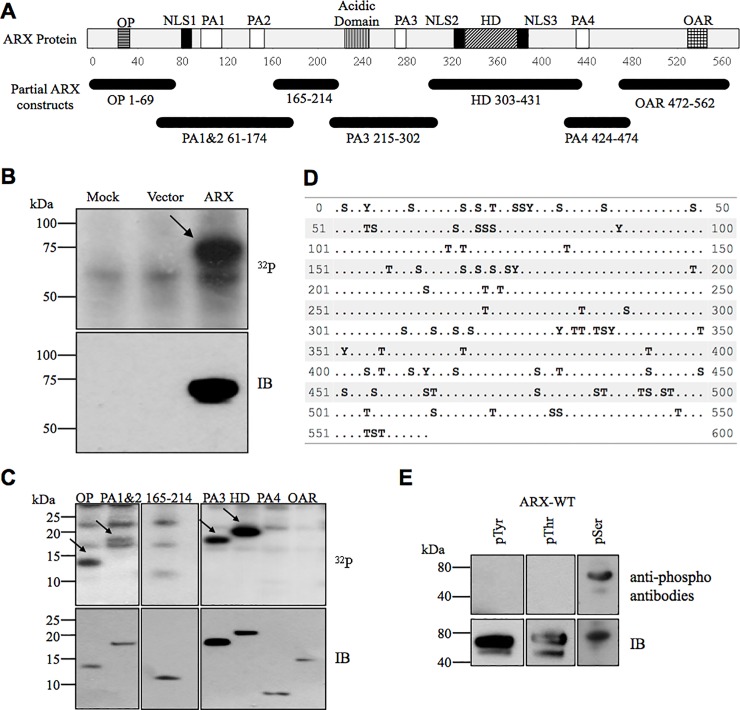
Multiple phosphorylation sites exist in ARX.(A) Schematic diagram of the ARX protein structure and position of partial constructs. Known functional domains are highlighted, octapeptide (OP) in horizontal stripes, nuclear localisation sequences (NLS) in black, polyalanine tracts (PA) in white, acidic domain in vertical stripes, homeodomain (HD) in diagonal stripes and Aristaless domain (OAR) in crosshatching. Partial constructs are named after the functional domain or the amino acids included and are shown below the protein. (B) HEK293T cells transfected with Myc-tagged full-length ARX construct were [32P] labelled, lysed and immunoprecipitated with an anti-Myc antibody and subjected to SDS-PAGE. Phosphorylated proteins visualised by autoradiography (arrow in upper panel). Presence of Myc-ARX protein was confirmed by immunoblotting (IB) using an anti-Myc HRP conjugated antibody (lower panel). Cells transfected with pCMV-Myc expression vector and untransfected cells were included as controls. These results are representative of at least two independent experiments. (C) Partial ARX constructs subjected to in vivo labelling assay as described for (B). (D) Serine, threonine, and tyrosine amino acids highlighted within the ARX protein. E) Immunoprecipitated Myc-ARX proteins were separated by SDS-PAGE and transferred to nitrocellulose membrane for immunoblotting with a 4G10 anti-phosphoTyrosine antibody (pTyr), an anti-phosphoThreonine antibody (pThr) or an anti-phosphoserine antibody (pSer). Presence of ARX was confirmed by immunoblotting using an anti-Myc antibody (bottom panel). Treated HEK 293T cells were included as positive controls; Pervanadate for pTry and CalyculinA for pThr (S1 Fig). Separate blots are boxed with a black outline.